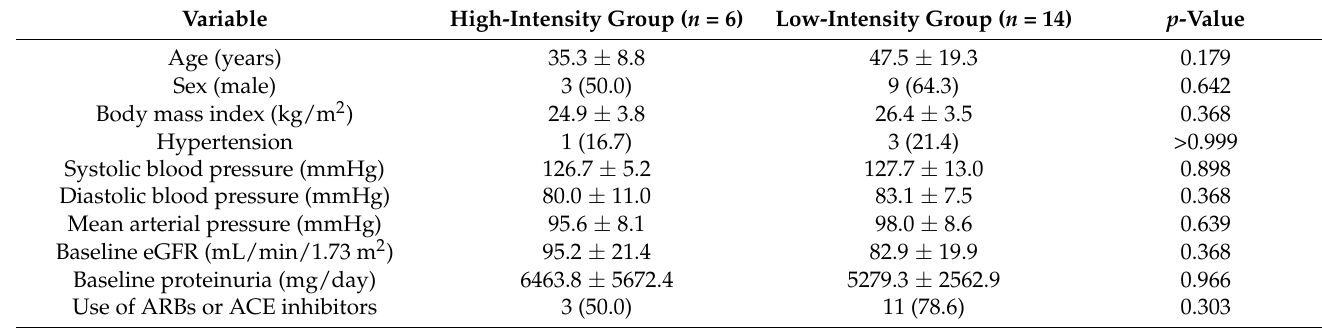
Table 3. Baseline characteristics of the high and low-intensity groups in the retrospective study.